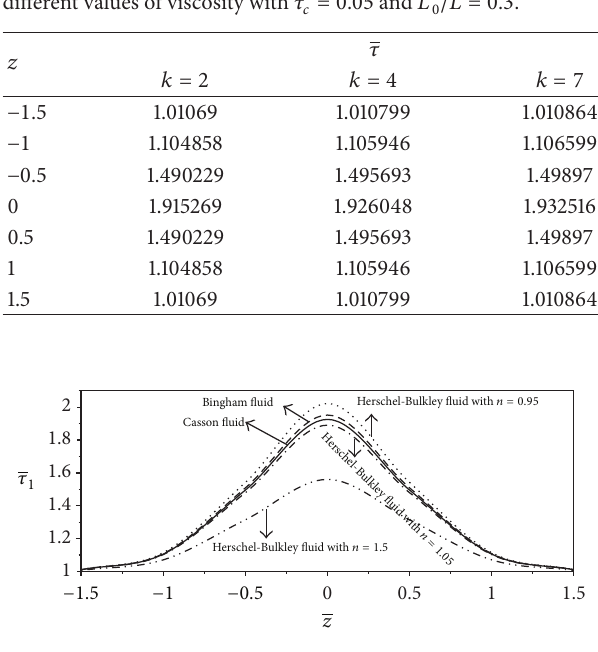
Table 1: Variations of the skin friction 𝜏 1 with axial distance for